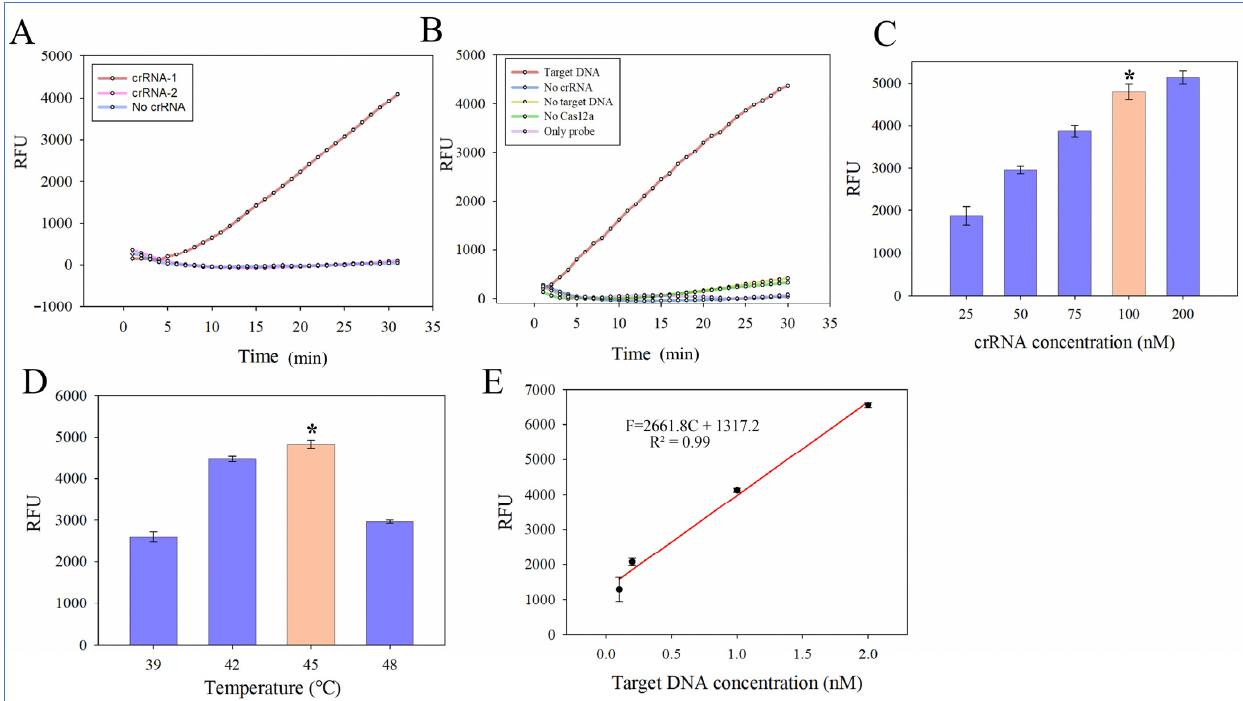
Figure 4. Optimization of the RAA-CRISPR/Cas12a assay. ( A ) Fluorescent intensity results for different crRNAs (N = 3). ( B ) Fluorescent intensity results of the RAA-CRISPR/Cas12a assay with missing elements (N = 3). ( C ) Fluorescent intensity results for di ff erent concentrations of crRNAs (N = 3). ( D ) Fluorescent intensity results for di ff erent CRISPR reaction temperatures (N = 3). ( E ) The calibration curve of the biosensor for synthetic fragments (N = 3). * indicates signi fi cant di ff erence at p < 0.05.